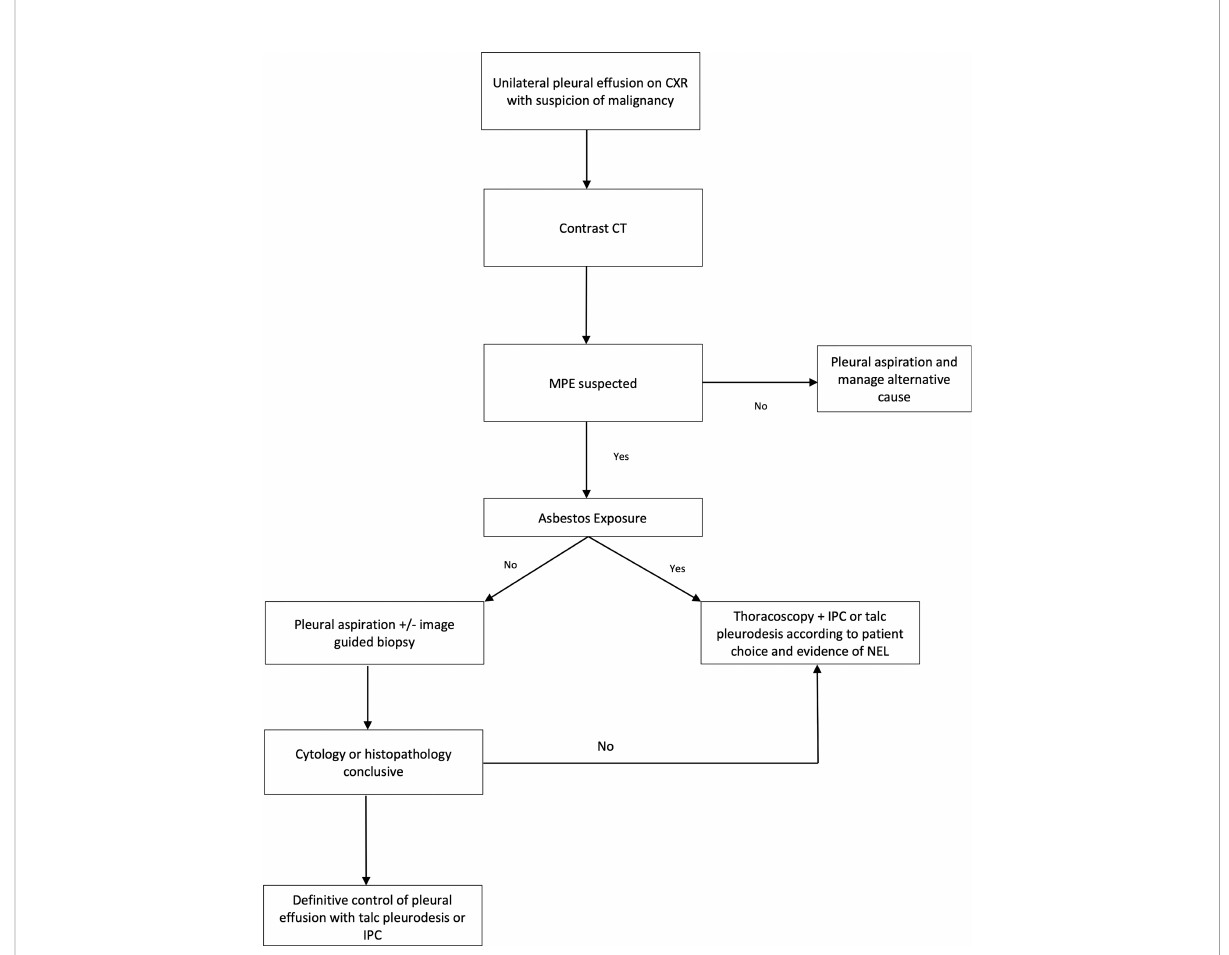
FIGURE 2 Authors suggested pathway for the investigation and management of suspected malignant pleural effusion based on current evidence. Diagnostic yield of tests noted: Pleural Aspiration 37-43% (11), Image guided pleural biopsy 84-93% (30), Thoracoscopy 95% (33). MPE, malignant pleural effusion; CT, computed tomography; IPC, indwelling pleural catheter; NEL, non expansile lung. Asbestos exposure determined by either imaging features such us pleural plaques or patient reporting. Asbestos exposure of importance due to increase in pre-test probability of